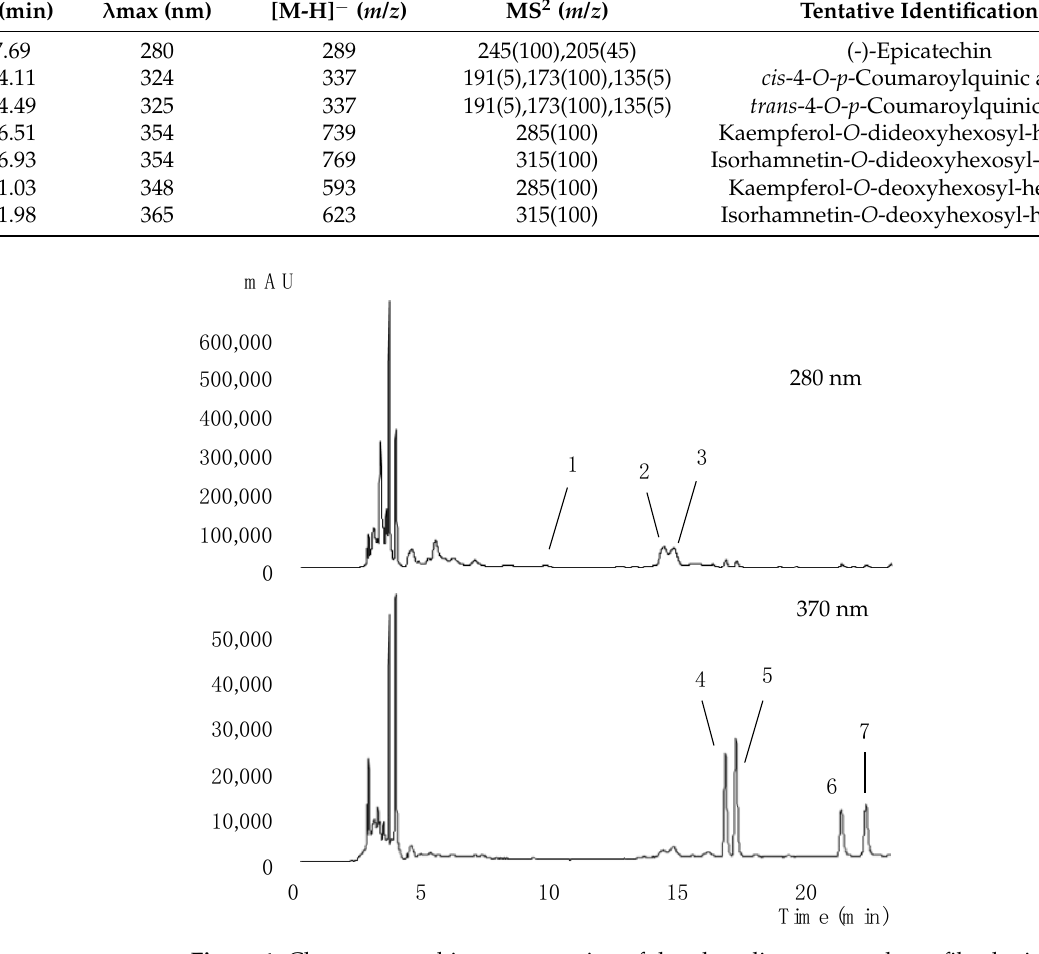
Figure 1. Chromatographic representation of the phenolic compounds profile obtained by HPLC- DAD under the optimal conditions for each extract.